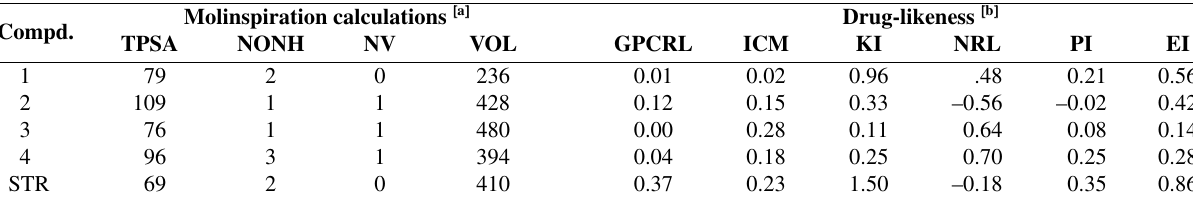
Table 2 . Molinspiration calculations of staurosporine derivative ( 1 ) and its complexes ( 2 – 4 ). Compd.